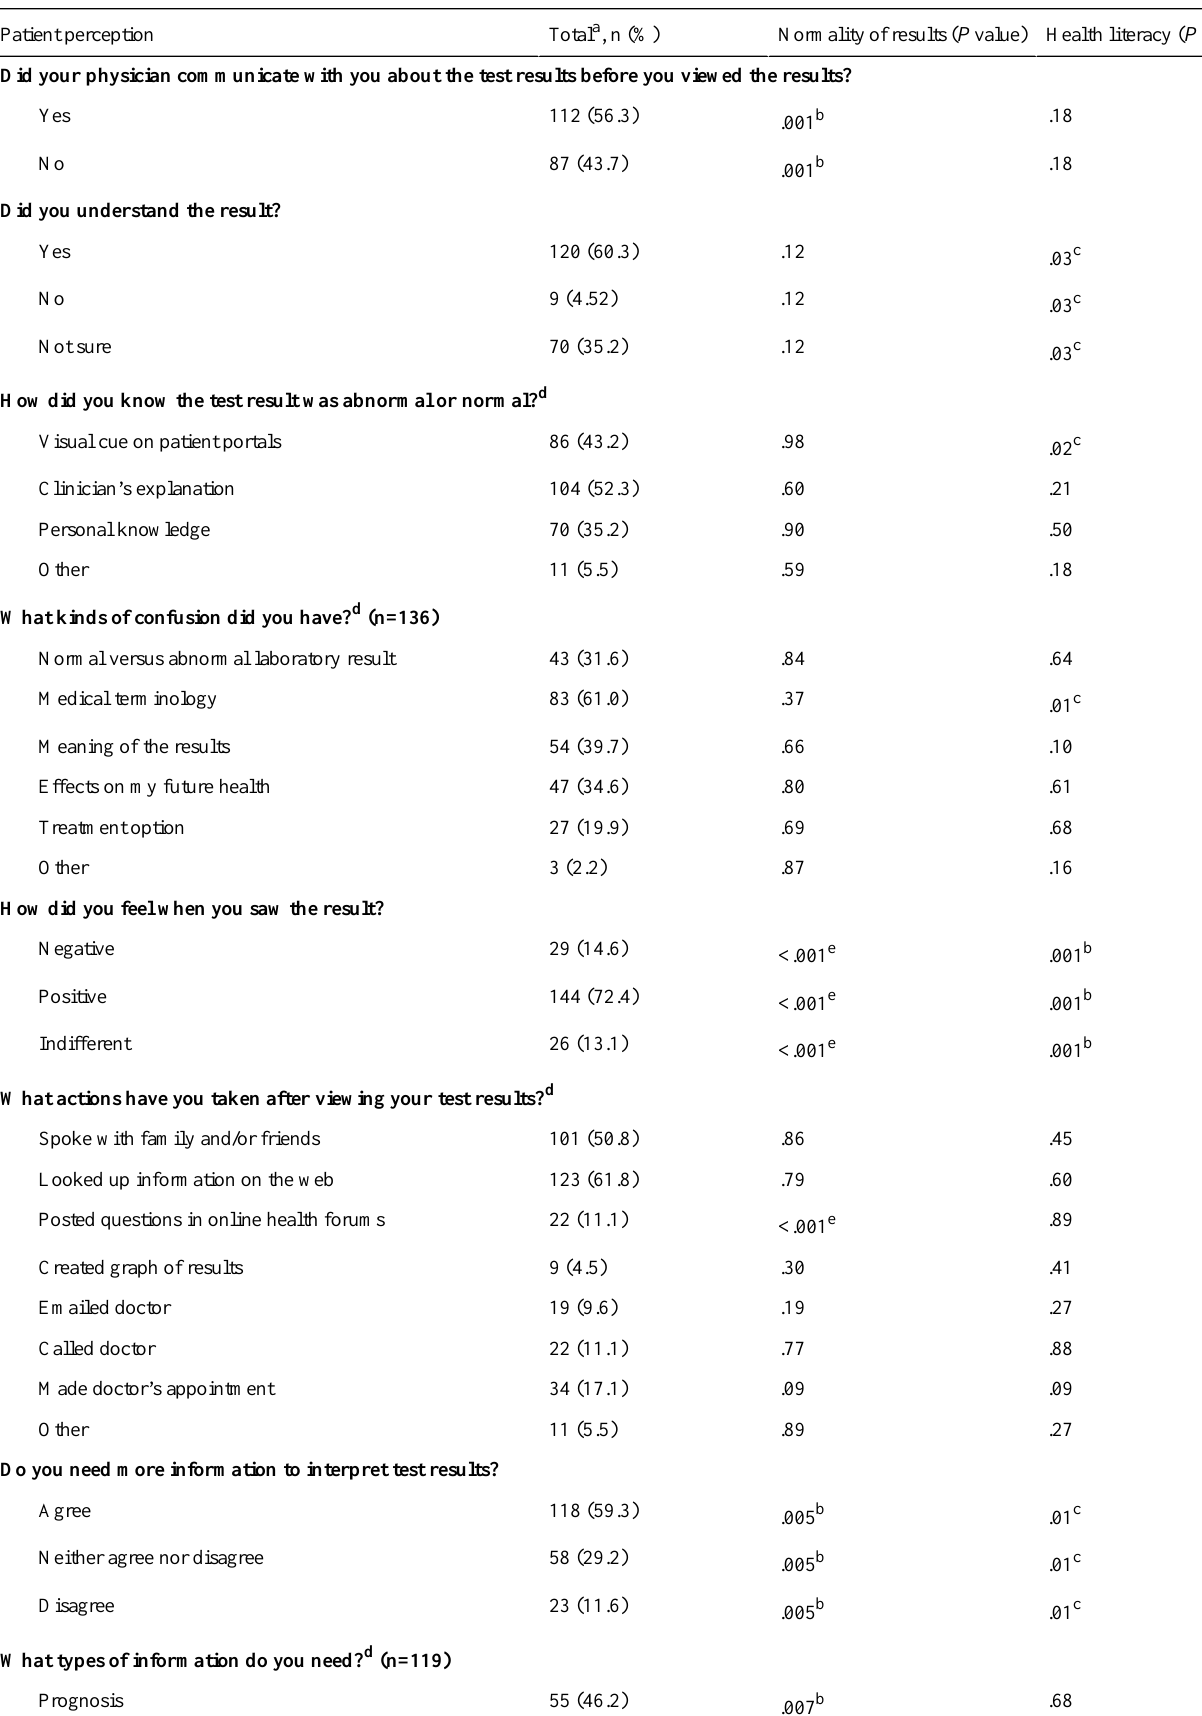
Table 4. Patient perceptions of interpreting test results and the association to normality of laboratory test results and health literacy (n=199).